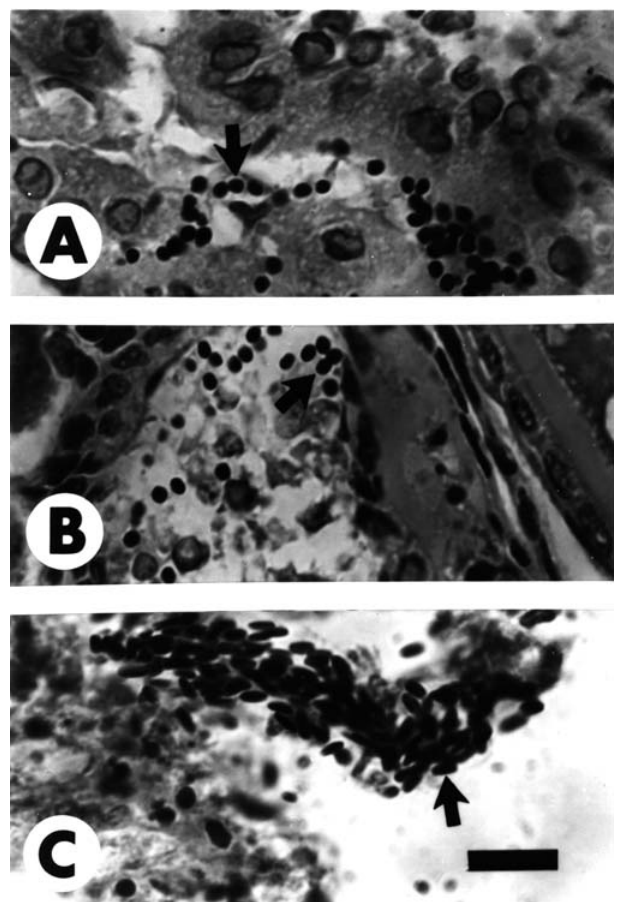
Fig. 16. Light micrographs through mature ovaries of the three species of Attonitus ; arrows, spermatozoa; bar, 10 µ m. A, Attonitus ephimeros , SL 33.1 mm (USNM 349696). B, A . irisae , SL 36.6 mm (USNM 349704). C, A . bounites , SL 43.0 mm (USNM